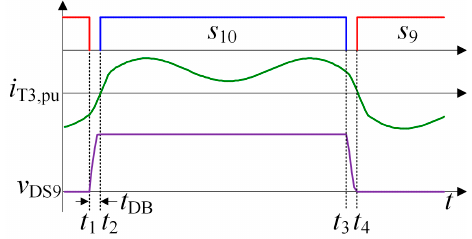
Figure 9. Critical ZVS realization process of switches in port 3.